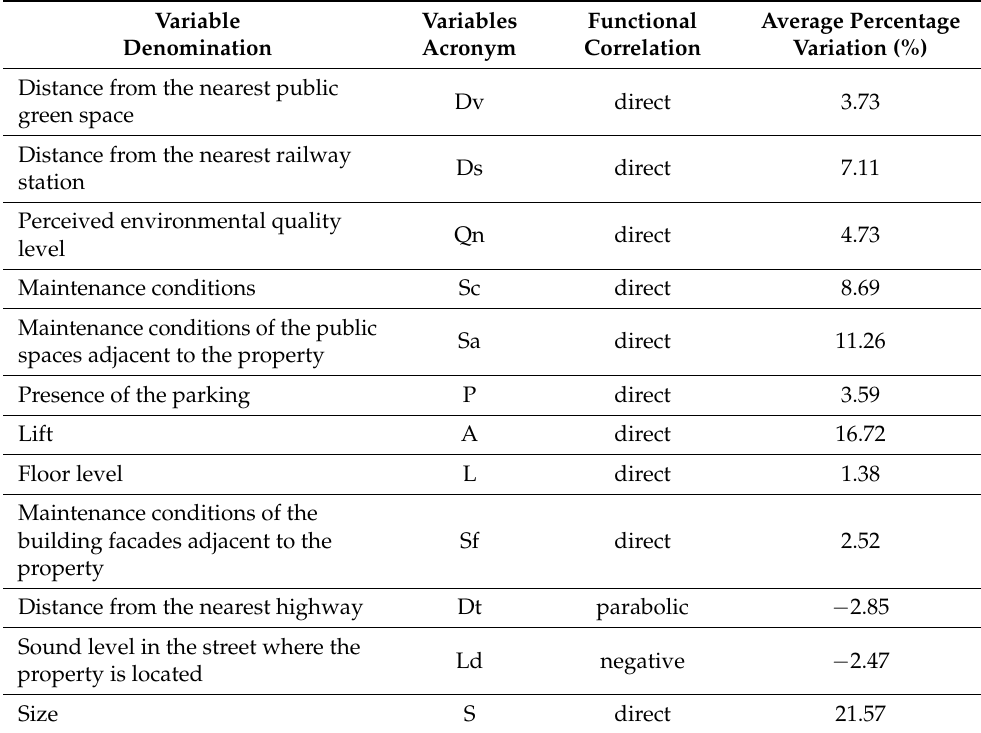
Table 5. Total selling price average percentage variation for the variables chosen by the model for the OMI peripheral area of the city of Bari.